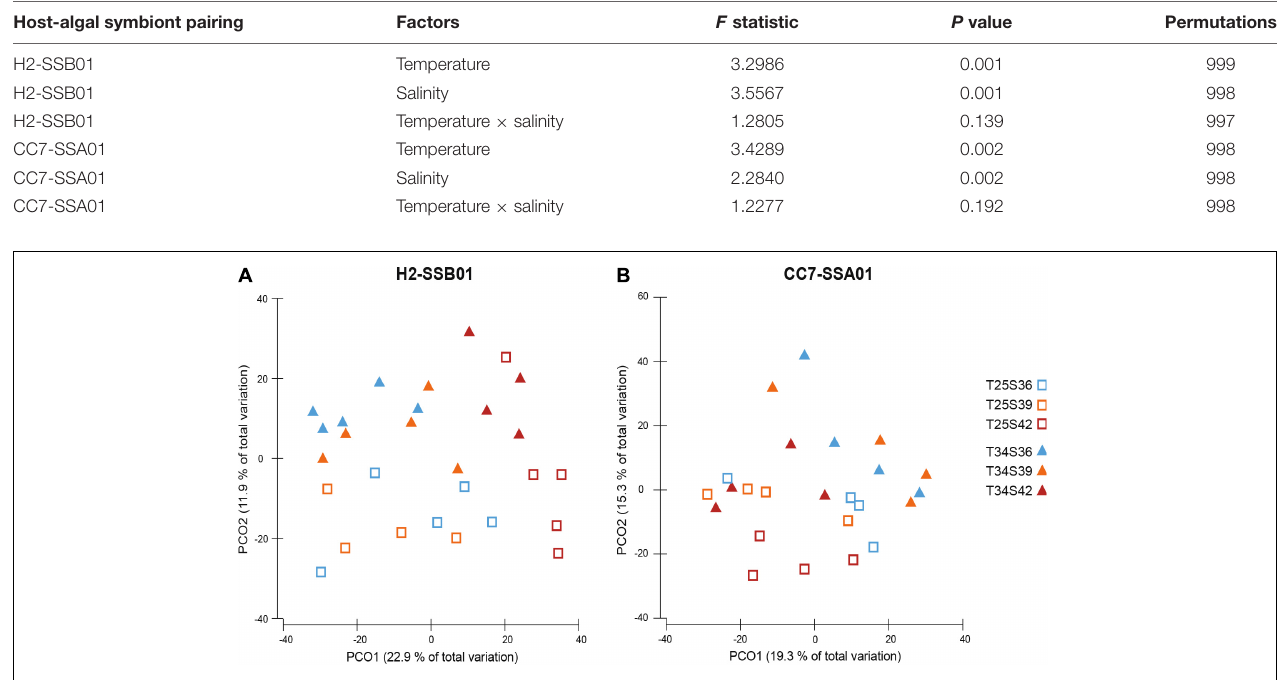
TABLE 2 | Summary statistics of two-factorial PERMANOVA based on Bray–Curtis dissimilarity of bacterial taxa abundances (OTUs) for both host-algal symbiont pairings.